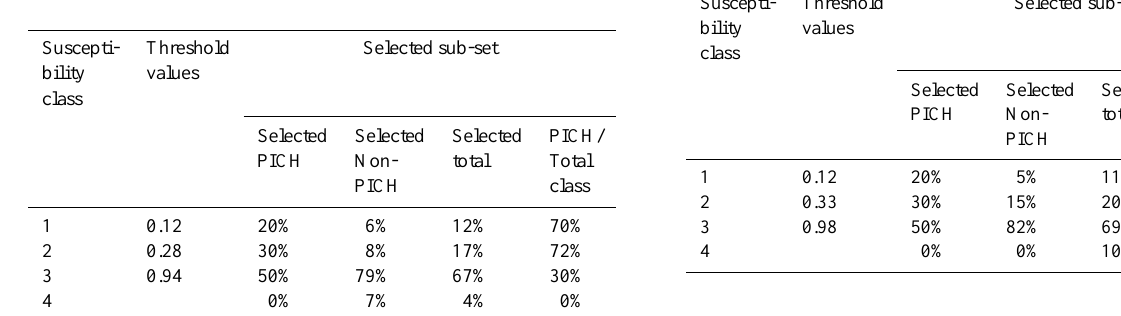
Table 3. Illustration of the efficiency of a sorting based on the altitude.